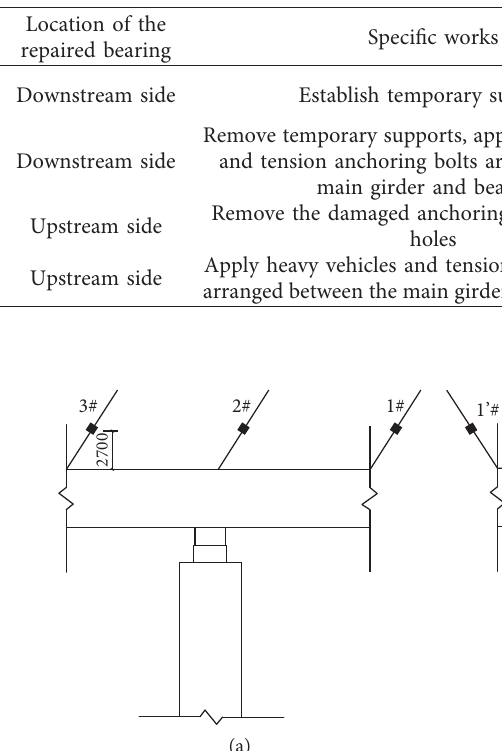
Table 1: Details of repair process and monitoring